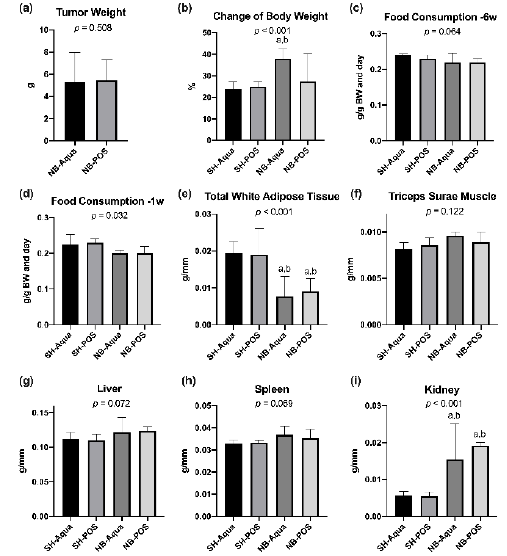
Figure 1. ( a ) Comparison of tumor weight; changes in ( b ) body weight, food consumption ( c ) 6 weeks and ( d ) one week prior to euthanasia; normalized weight of ( e ) total white adipose tissue, ( f ) triceps surae muscle, ( g ) liver, ( h ) spleen, and ( i ) kidney. NB—neuroblastoma; SH—sham; POS—prebiotic oligosaccharide; a— p < 0.05 vs. SH-Aqua; b— p < 0.05 vs.